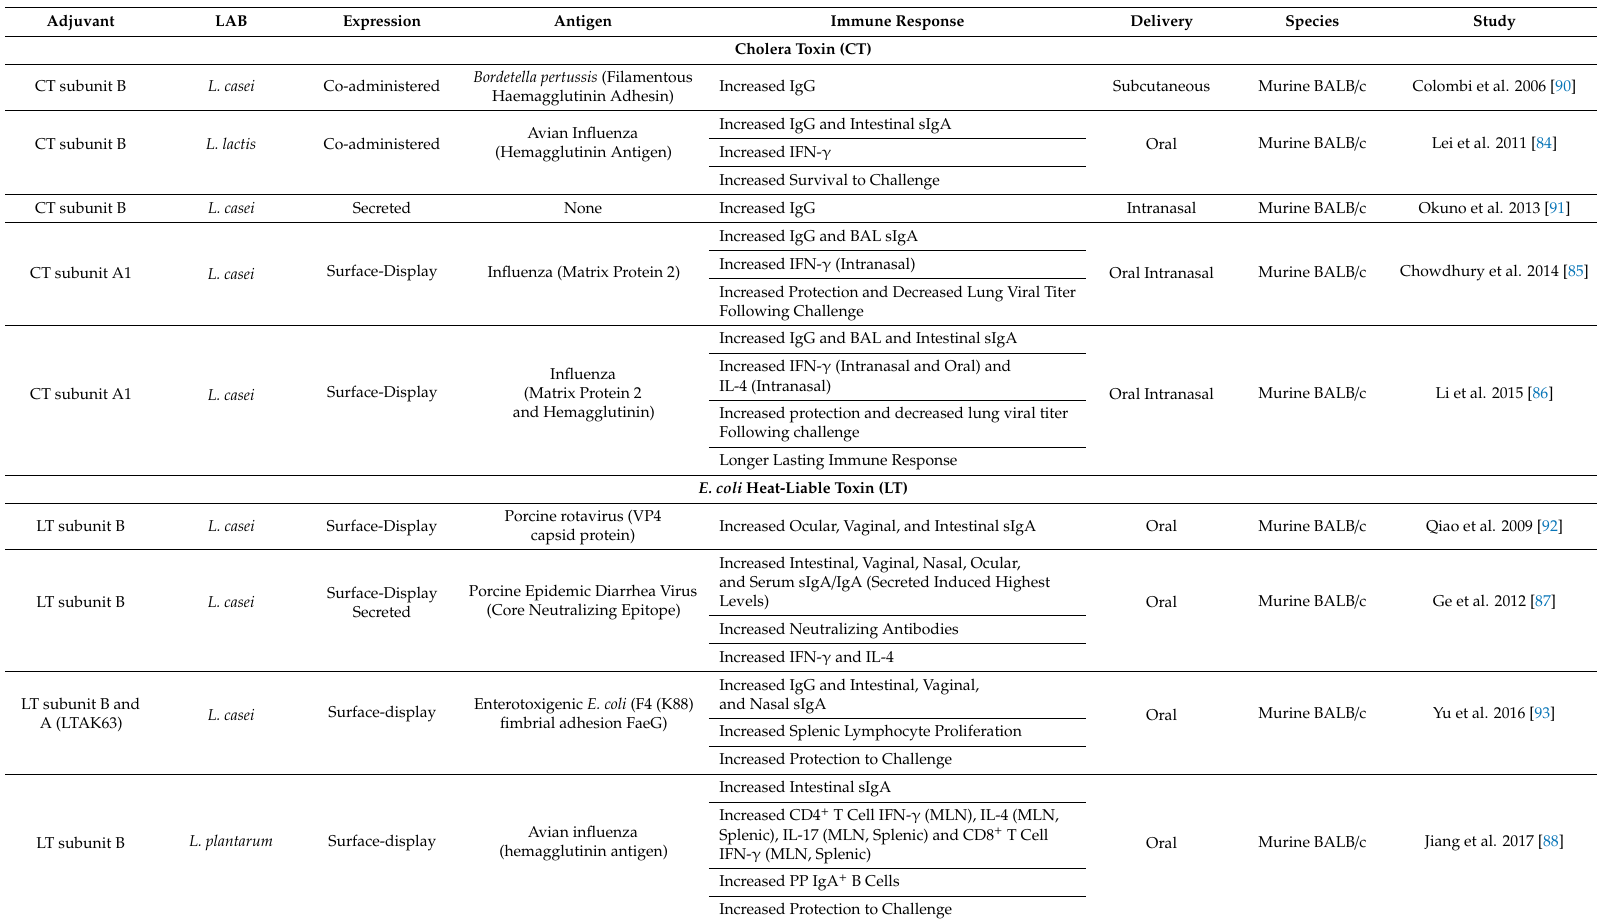
Table 3. Bacterial toxin adjuvant strategies for lactic acid